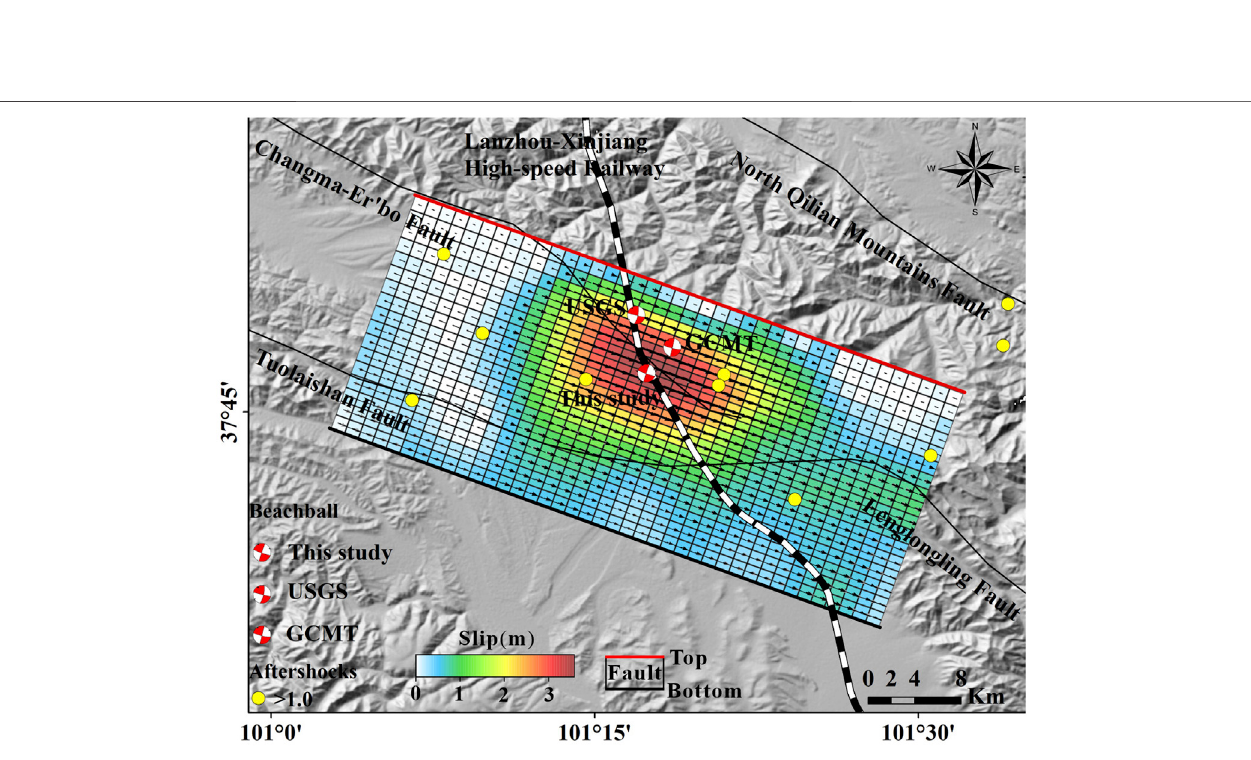
FIGURE 8 | The surface projection of co-seismic slip distribution, the square size is 1 × 1 km, and the small black arrow indicates local co-seismic slip directions.